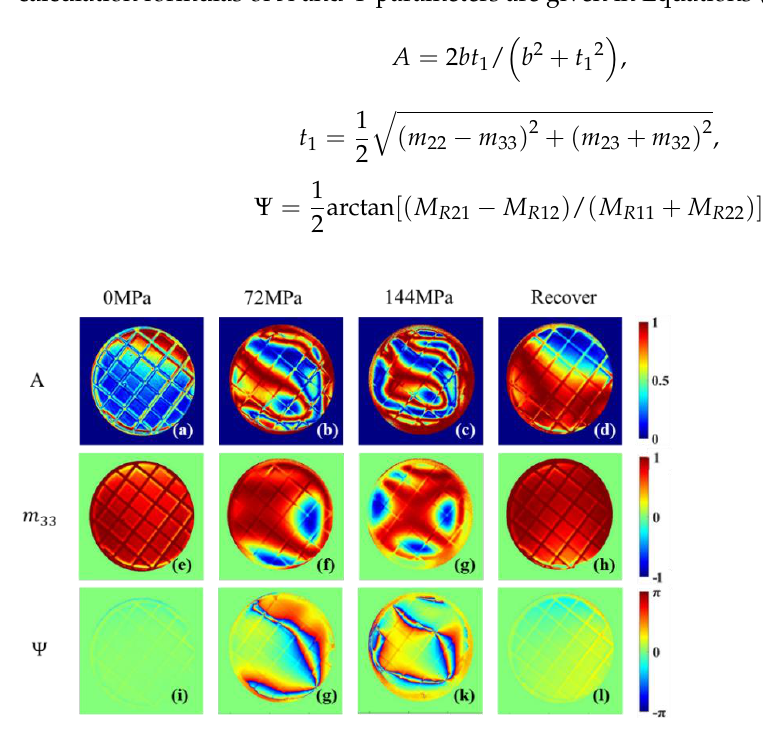
Figure 13. A , 𝑚 33 , 𝛹 images of sample at 0 MPa, 72 MPa, 144 MPa and images after 24 h recovery. Figure 13. A , m Ψ images of sample at 0 MPa, 72 MPa, 144 MPa and images after 24 h 33 ,